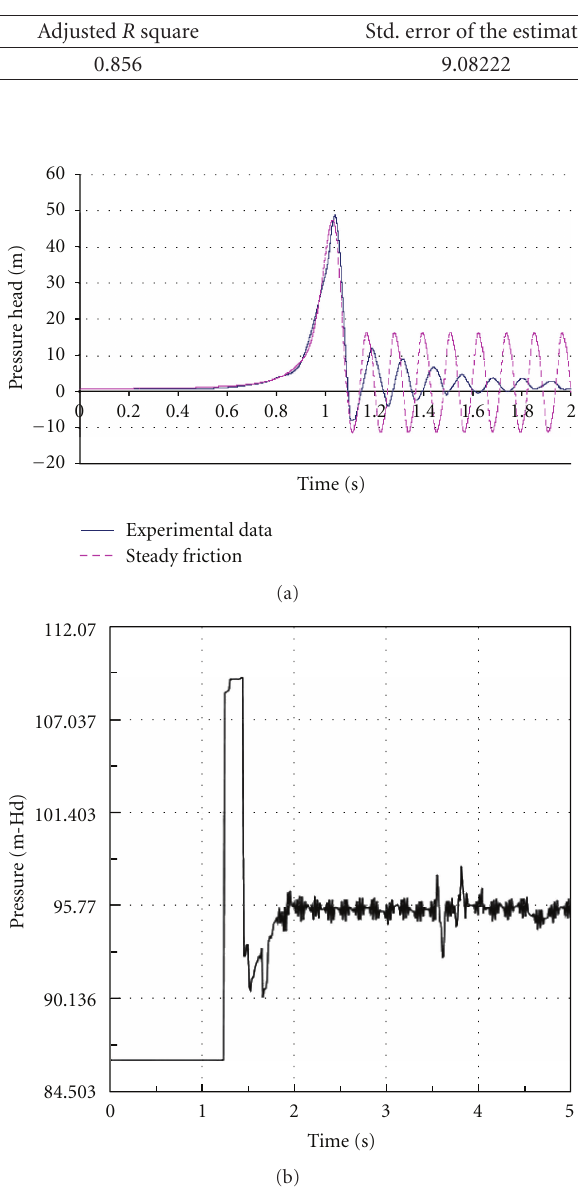
Figure 4: Pressure head histories for a single piping system using (a) steady friction and (b) steady